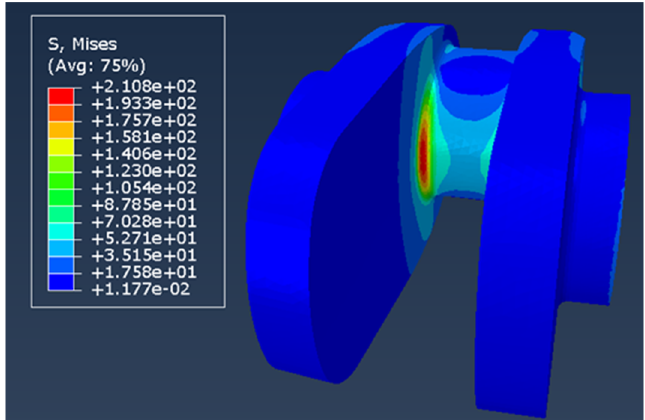
Table 3. Components of the stress sensor of crankshaft N0 from different sources. Figure 11. The stress distribution of crankshaft N0 (under the given bending moment). Figure 11. The stress distribution of crankshaft N0 (under the given bending